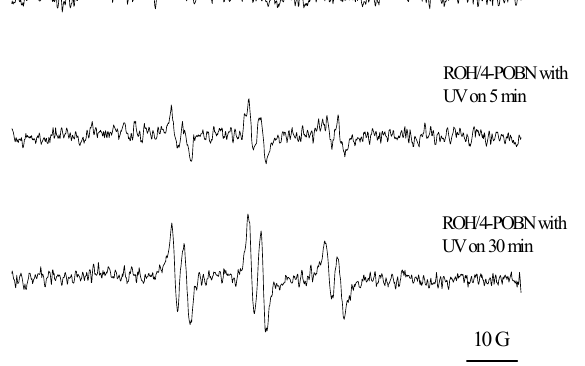
Figure 7 : ESR measurements of 0.35 mg/ml ROH in 70% ethanol in water containing 200 mM spin trap α -(4-Pyridyl-1-oxide)-N-tert-butylnitrone (POBN) after being photoirradiated with UVA light at wavelength 320 nm. Conventional ESR spectra were obtained with a Varian E-109 X-band spectrometer. ESR signals were recorded with 15 mW incident microwave and 100 kHz field modulation of 1.25 G.